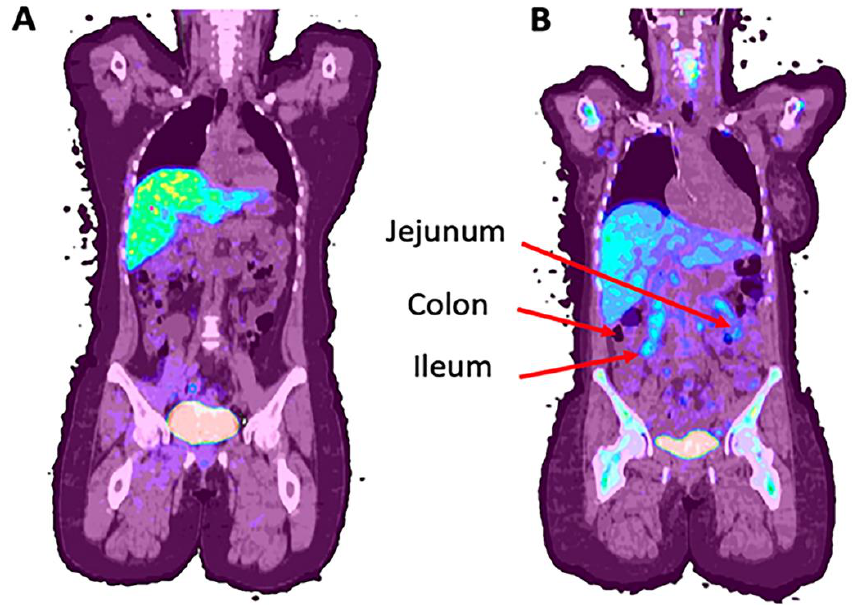
Figure 3. Examples of 18 F-FLT uptake in patients with ( A ) no GvHD and ( B ) jejunum and ileum uptake c/w GvHD (NCT01338987). (Original data). uptake c/w GvHD (NCT01338987). (Original